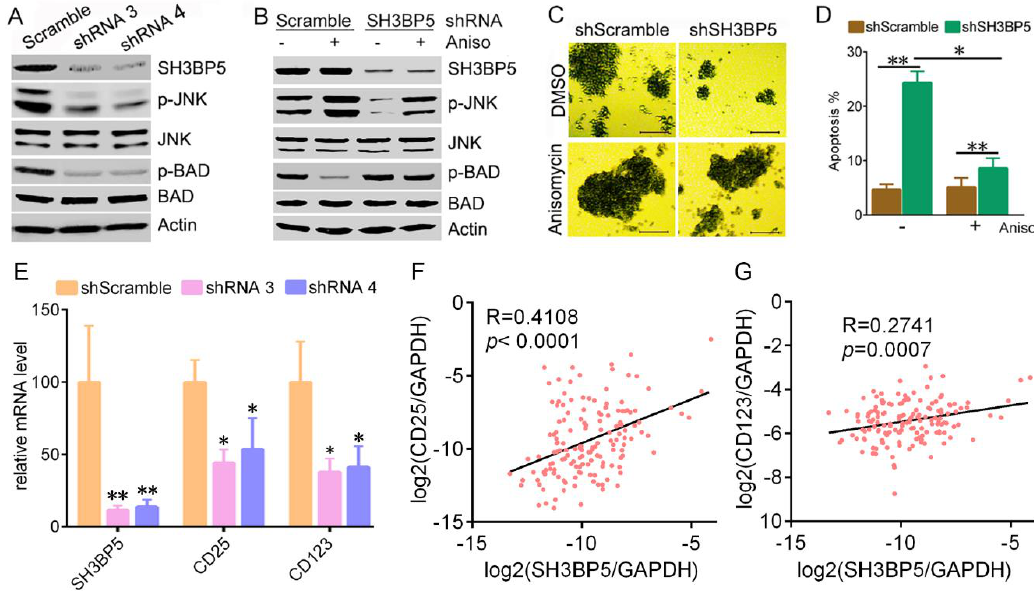
Figure 6. SH3BP5 knockdown inhibited activation of JNK-BAD signaling and expression of